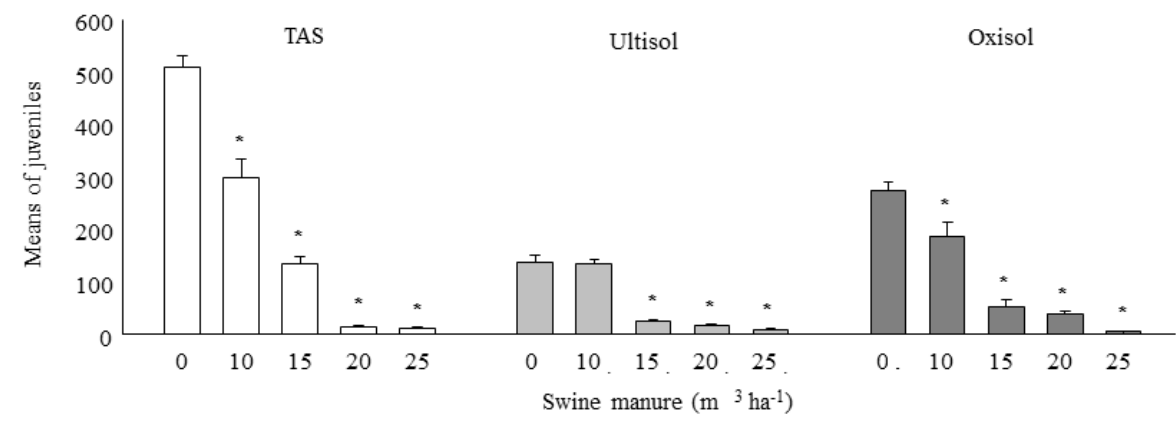
Figure 2. Mean of juveniles of Folsomia candida in Tropical Artificial Soil (TAS), Ultisol and Oxisol with increasing concentrations of swine manure. *Significant statistical difference (p<0.05) by the Dunnett test. ( ┬ ). Standard deviation (n =